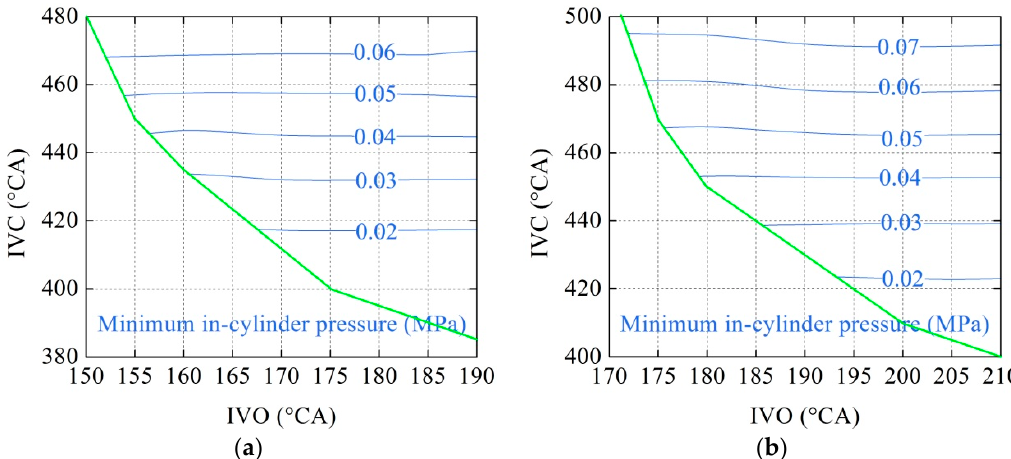
Figure 15. The minimum in-cylinder pressure of the inactive cycle: ( a ) 1200 rpm; ( b ) 1600 rpm.